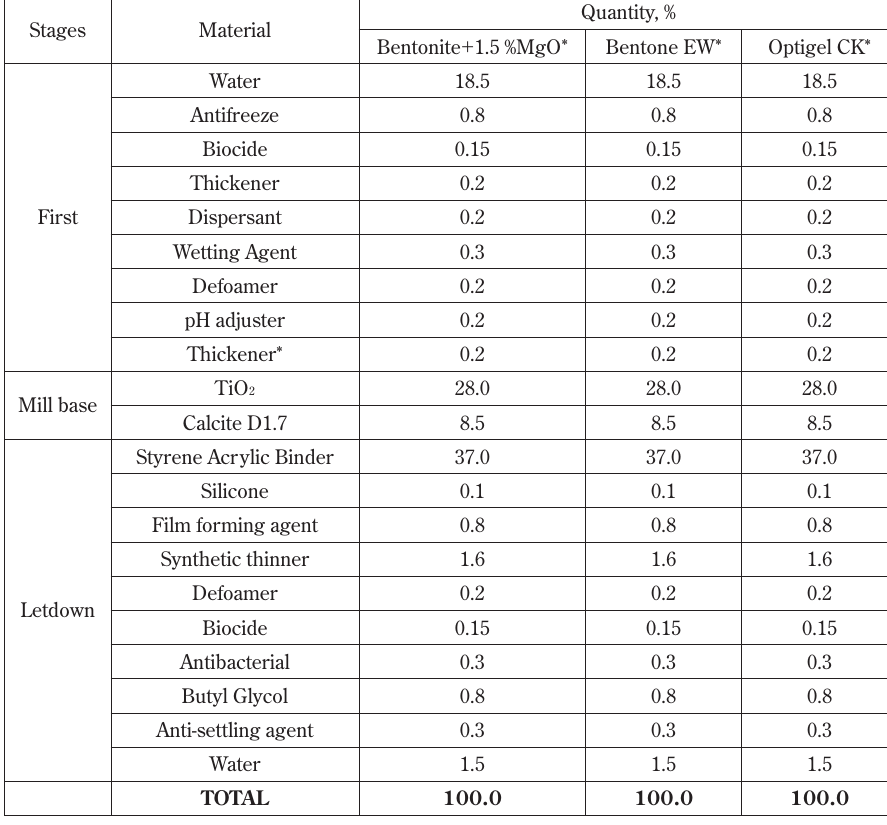
Table 6 Paint recipes with three different thickeners.